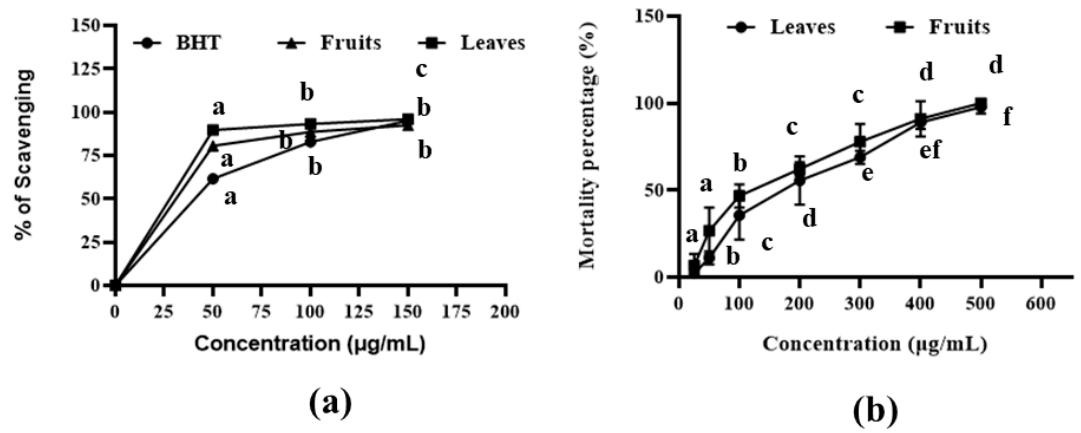
Figure 1. Antioxidant and cytotoxic activity of A. officinalis leaves and fruits extract. ( a ) DPPH scavenging activity of both leaves and fruits, and ( b ) mortality percentage of brine shrimp for cytotoxicity test where different significance letter indicates significant differences between mean ± SD of replication (n = 3) at a p < 0.05 significance level.